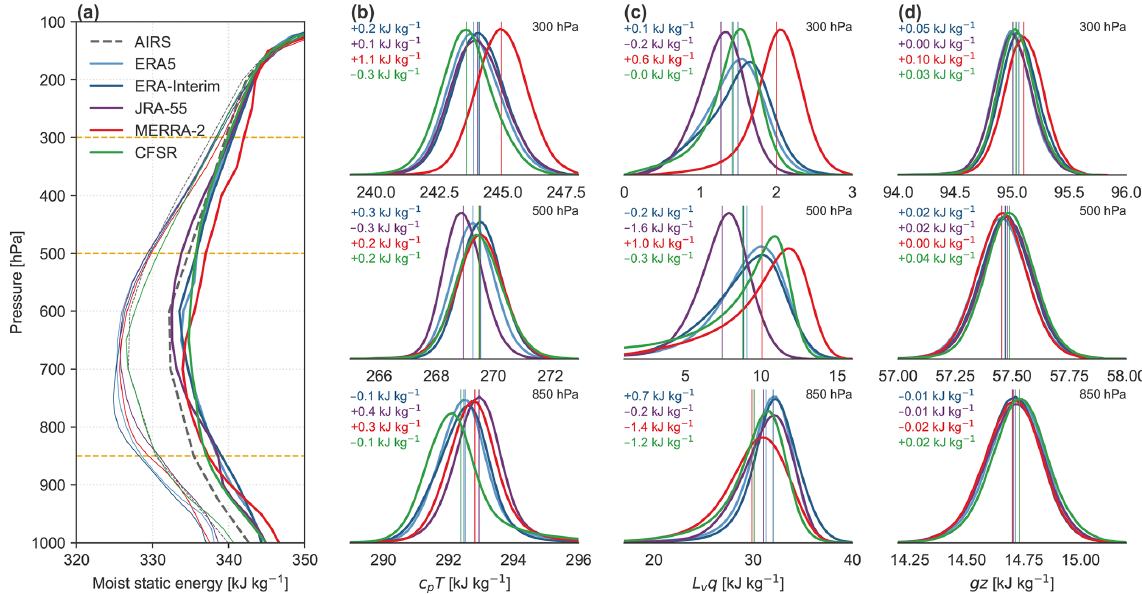
Figure 11. (a) Composite vertical profiles of moist static energy (MSE) for ERA5 (cyan), ERA-Interim (blue), JRA-55 (purple), MERRA-2 (red), and CFSR (green) averaged for the upper ( Q 4 ; thick lines) and lower ( Q 1 ; thin lines) quartiles of daily-mean LWCRE during 2001– 2010. Profiles calculated from AIRS observations (September 2002–December 2010; grey dashed lines) are conditioned on quartiles of daily-mean LWCRE from CERES SYN1Deg. At the right are distributions of the (b) temperature ( c p T ), (c) moisture ( L v q ), and (d) geopo- tential ( gz ) components of MSE for Q 4 from each reanalysis at the levels marked by yellow dashed lines in (a) : 850hPa (lower row), 500hPa (centre row), and 300hPa (upper row). Mean values are marked as vertical lines; biases in these mean values relative to the mean value from ERA5 are colour-coded at the upper left of each panel (each list from top: ERA-Interim, JRA-55, MERRA-2, and